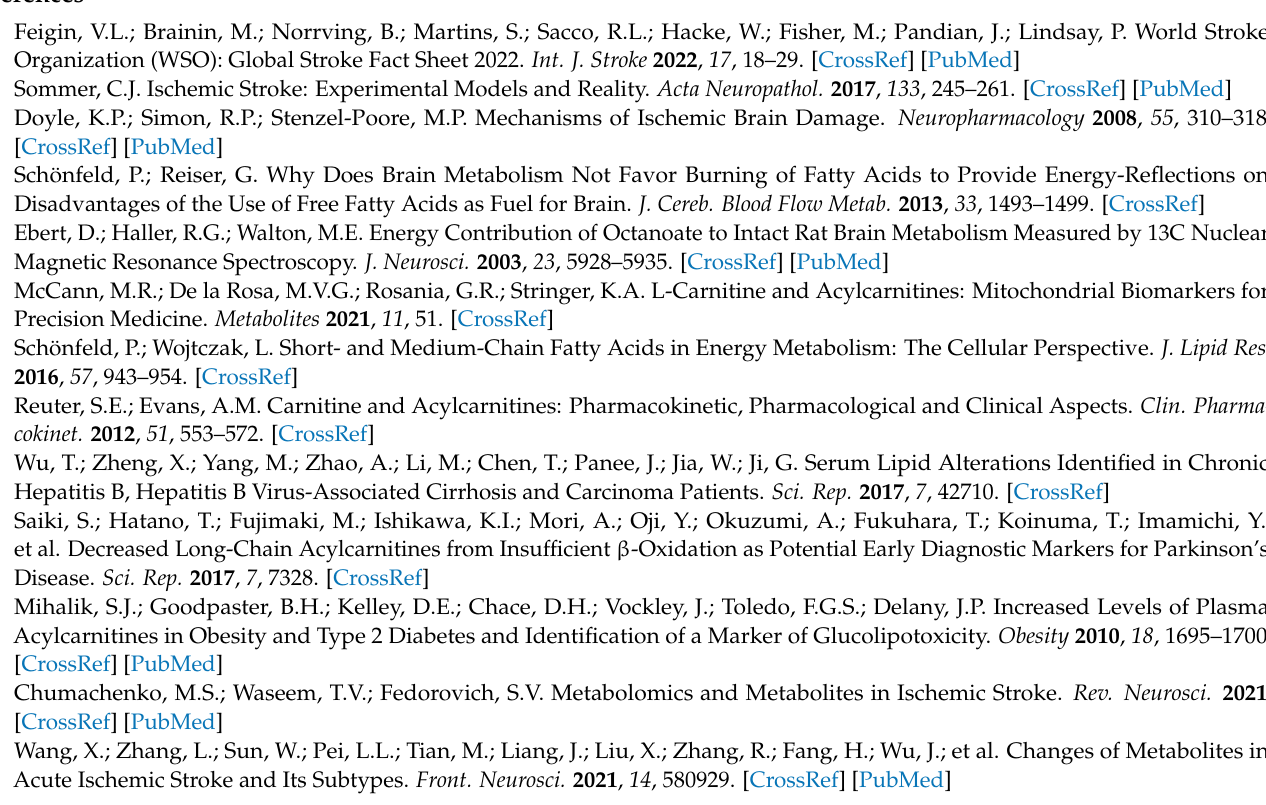
Table S3: Raw data for Figure 1b; Table S4: Ionization suppression data (%) from Figure 1b; Figure S1: One-point calibration data for carnitine and C16-carnitine; Figure S2: MS/MS spectra of carnitine-d3; Figure S3: MS/MS spectra of C18-carnitine-d3; Figure S4: Ion images of carnitine and C16-carnitine from three biological replicates; Figure S5: Ion images of carnitines with different normalizations; Figure S6: Image of carnitine-d3/C18-carnitine-d3 ratio; Figure S7: Image of PC 22:0 K + /Na + adduct ratio; Table S5: Average fold change of accumulated acylcarnitines in the ischemic area; Figure S8: Ion images of glucose, LPC 16:0 and ROI analysis of glucose, LPC 16:0, FA 18:1, FA 18:2; Figure S9: ROI analysis of carnitine, C2-, C3-, C5- and C12-carnitine; Figure S10: Schematic overview of the carnitine shuttle